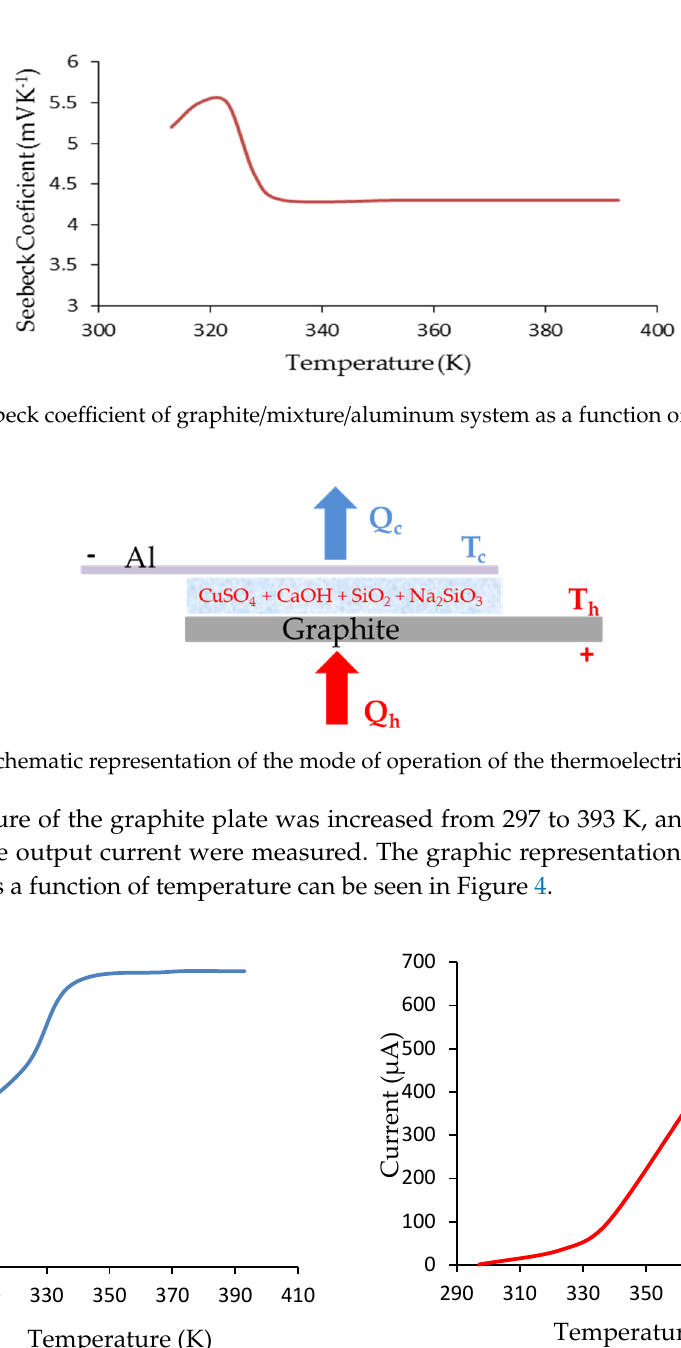
Figure 4. Thermoelectric generator: ( a ) the voltage; ( b ) the output current. The output voltage ranges from 375 to 850 mV in the range 297–393 K, and the output current ranges from 1 to 658 µA in the same temperature range.